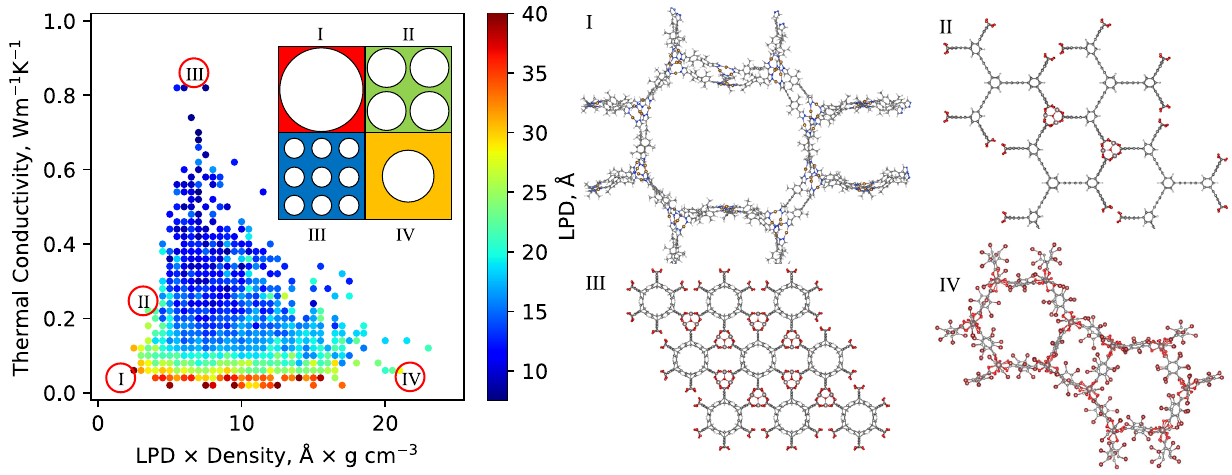
Fig. 5 Images of hypothetical MOF structures from different regions of the structure-thermal conductivity space. The fi gure on the left illustrates where each structure is located with respect to the product of the density and the largest pore diameter (LPD): (I) very low density and very high LPD, (II) low density and high LPD, (III) high density and low LPD, (IV) high density and high LPD. The inset fi gure illustrates how structures in each region look qualitatively with respect to the relative pore size and density. The pore diameter is adjusted proportionally to the average pore diameter in each